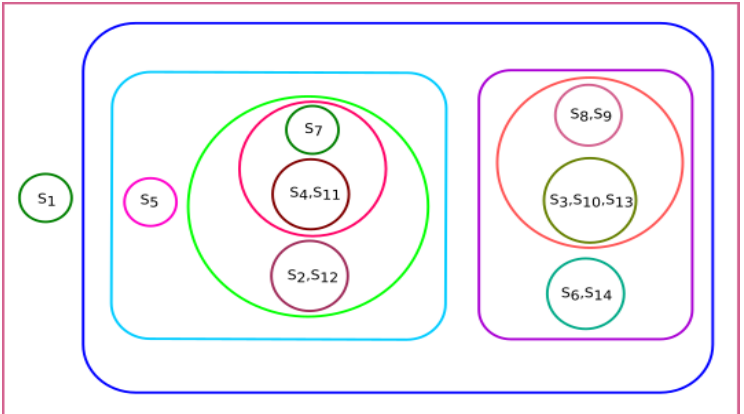
Figure 12. Clusters drawn from phylogenetic tree based on Hurst exponent. Here, S i indicates the species name as specified in Table